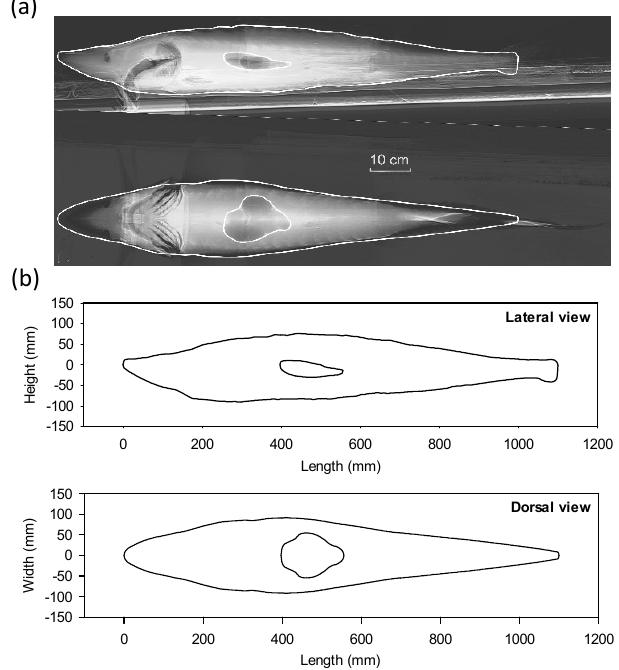
Figure 3. The body and swimbladder morphology of the examined Chinese sturgeon: ( a ) images by computed tomography; and ( b ) digitalized morphology in lateral view and dorsal view.